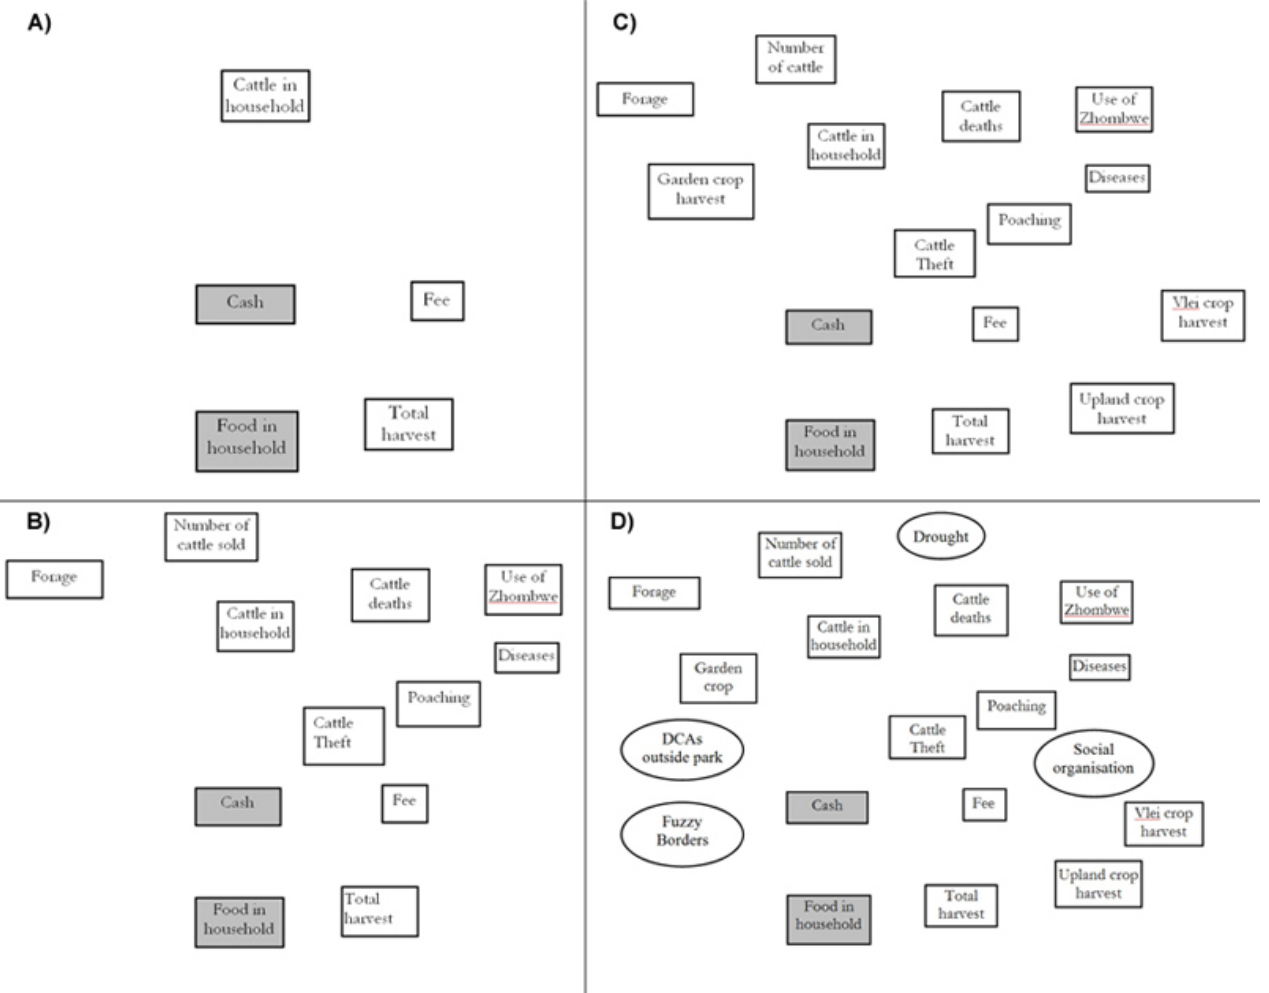
Fig. 3. Stepwise construction of a cattle-based rural livelihood system in southeastern Zimbabwe using fuzzy cognitive maps. (A) The central building blocks of the overall scheme. (B) Variables affecting the amount of cattle in the household are added to the central building blocks. (C) Variables determining total crop harvest are added. (D) Drivers determining the functioning of the system are added. Gray boxes are key indicators of the functioning of the livelihood; white boxes are variables; white circles are system